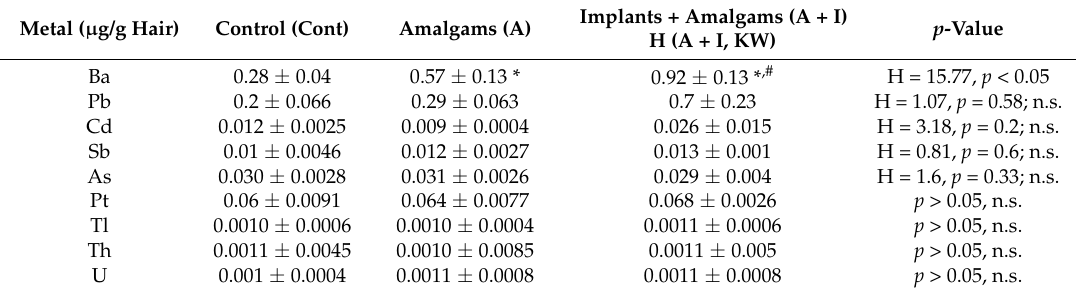
Table 4. Heavy metals of environmental exposure among experimental